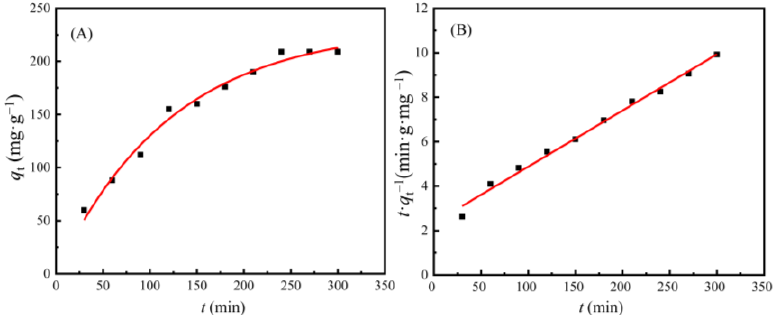
Figure 8. Adsorption kinetics of the AAM-MSMPM for the adsorption of Cd(II) ions: pseudo-first-